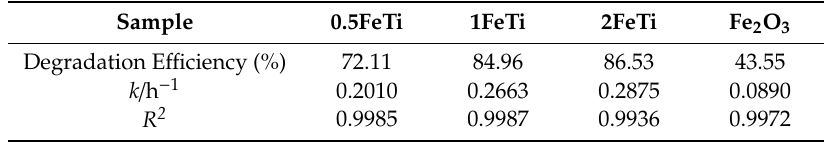
Figure 8. Photodegradation of RhB by Fe 2 O 3 and Fe 2 O 3 @TNT composites under visible light irradiation: ( A ) Degradation rate curves; ( B ) Pseudo-first correlation of kinetic constants. Table 3. Photodegradation parameters of the synthesized catalysts.